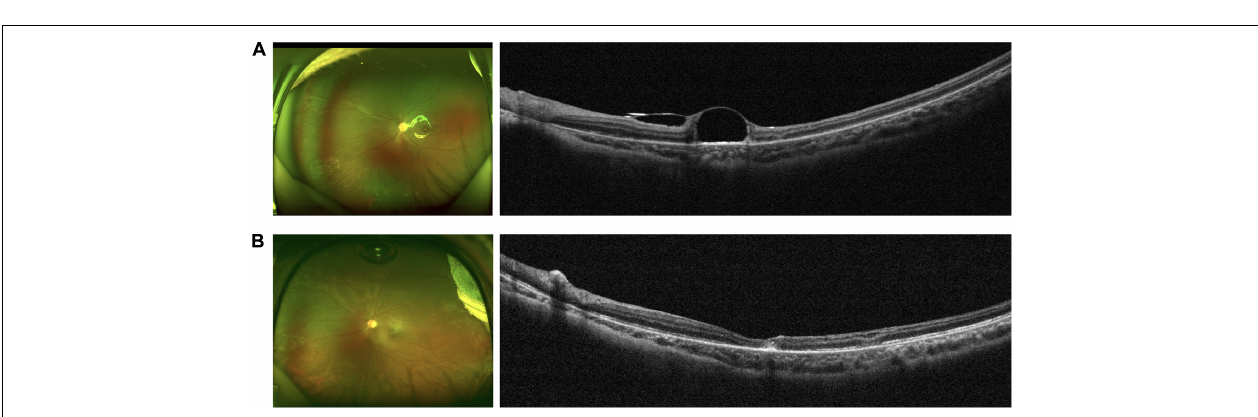
FIGURE 1 | Structure of the combined instrument. (A) 25-Gauge retrobulbar needle and 30-Gauge needle. (B) Combined 25-gauge retrobulbar needle with built-in 30-gauge needle. (C) Intraoperative operation.